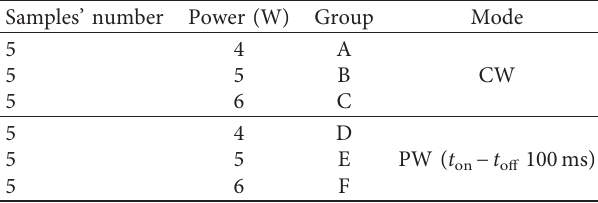
Table 1: The laser parameters used in the